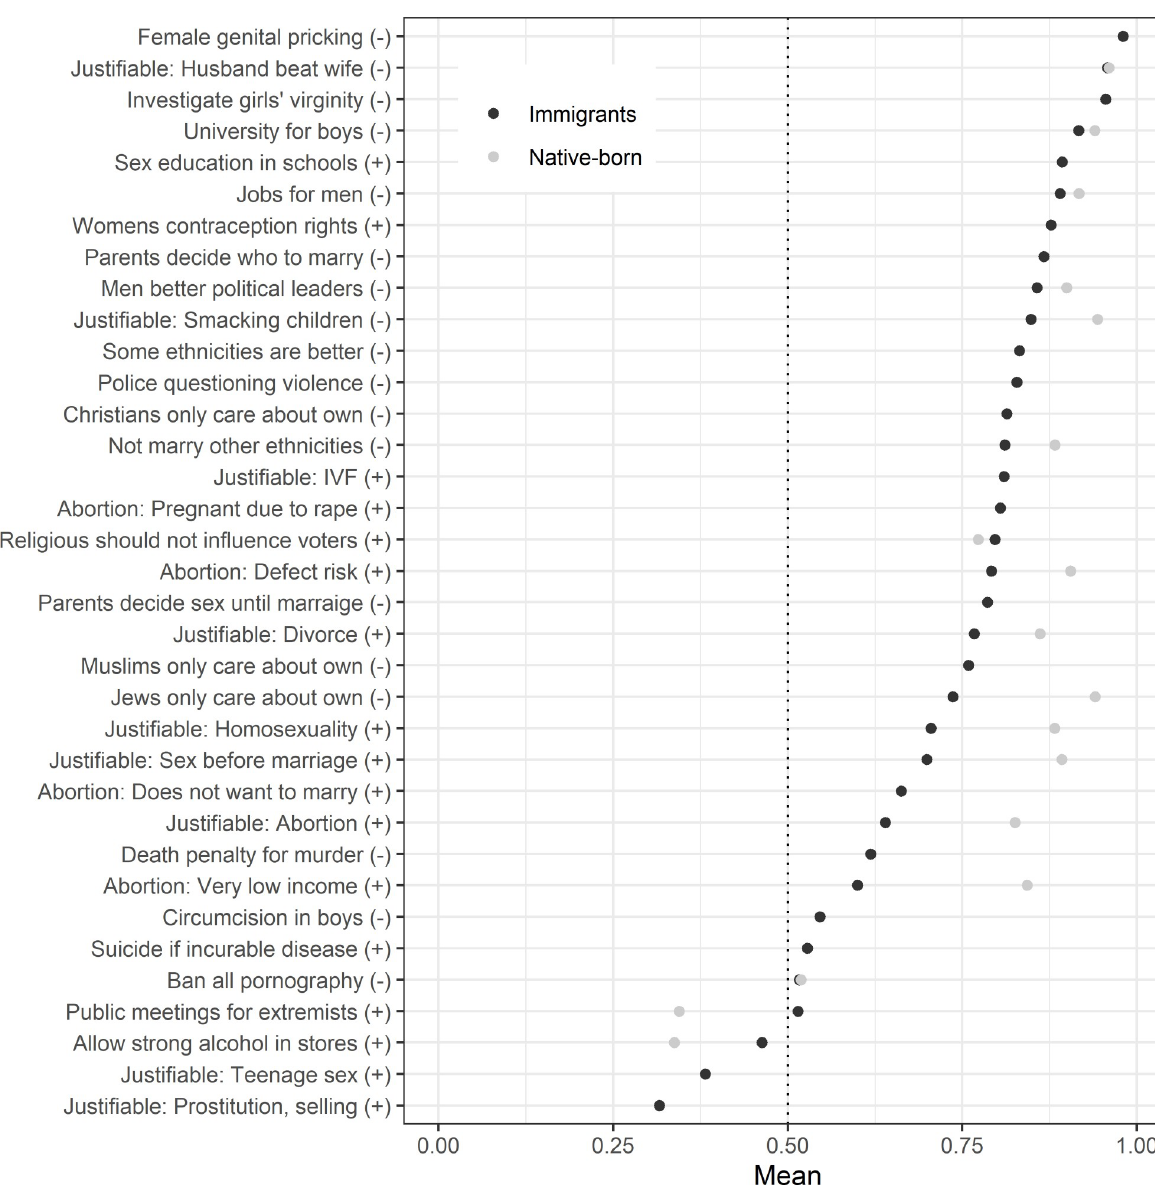
Fig 1. The social values of immigrants and native-born. Mean values, weighted for immigrants (and native-born when applicable). N for native- born varies across issues, see S1 Table. issue indicates whether agreement (+) or disagreement (-) to the statement of the issue repre- sents liberal values.